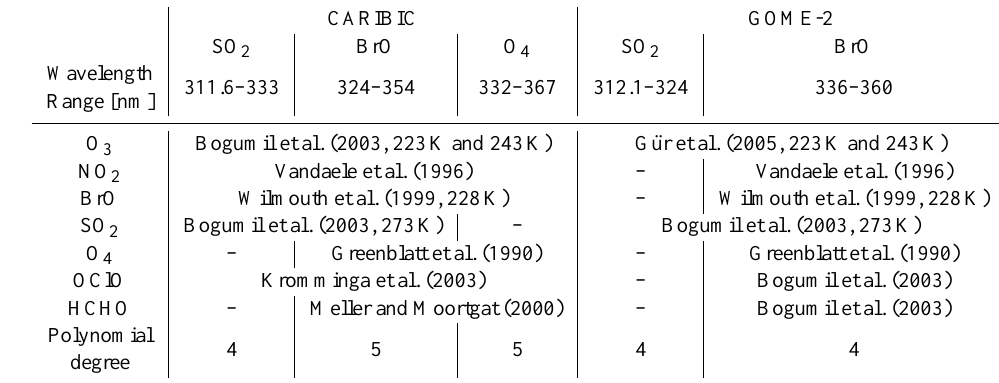
Table 1. DOAS retrieval settings for the CARIBIC and GOME-2 data